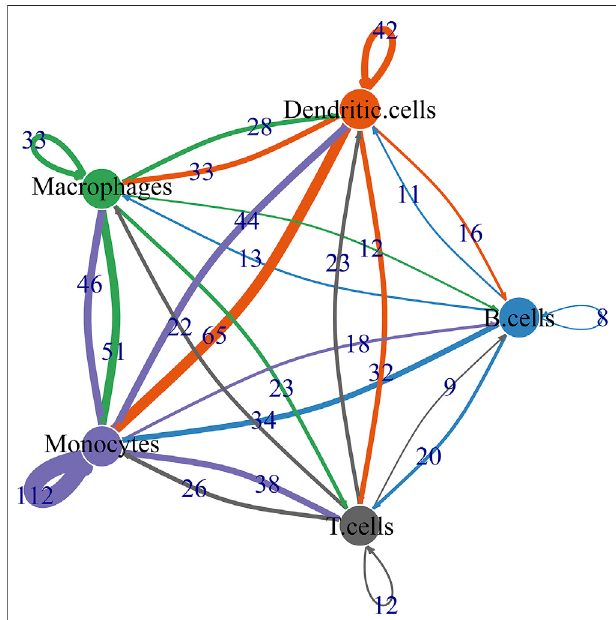
FIGURE 9 | Ligand-receptor network based on B cells, dendritic cells, macrophages, monocytes, and T